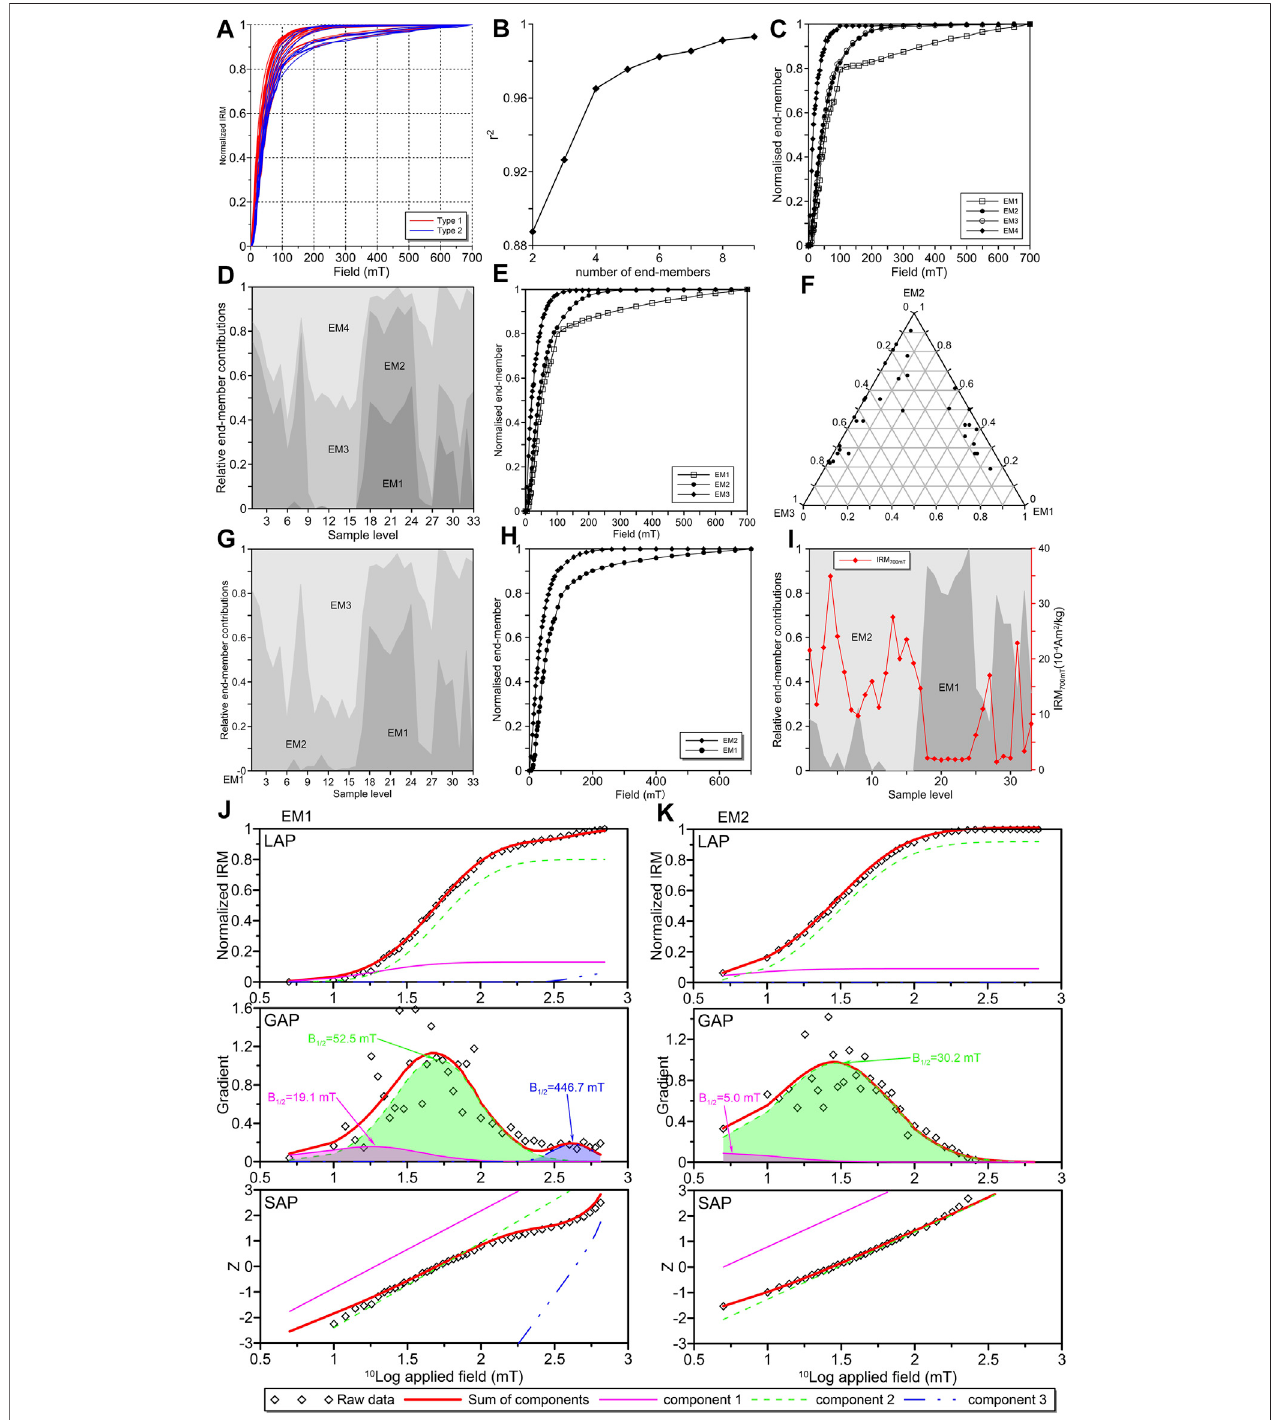
FIGURE 10 | IRM end-member modeling for the Cretaceous granite. (A) Normalized IRM acquisition curves for Type 1 and Type 2 samples. (B) Coef fi cient of determination versus the number of endmembers, there is a clear break-in-slope in the four end-member model. End-member modeling for the normalized IRM- acquisitioncurveswithfour (C,D) ,three (E – G) andtwo (H,I) end-members. (J,K) IRMcomponentanalysis(Kruiveretal.,2001)oftheend-membersinourfavorabletwo end-member model; colors and symbols are the same as in Panel 5 .